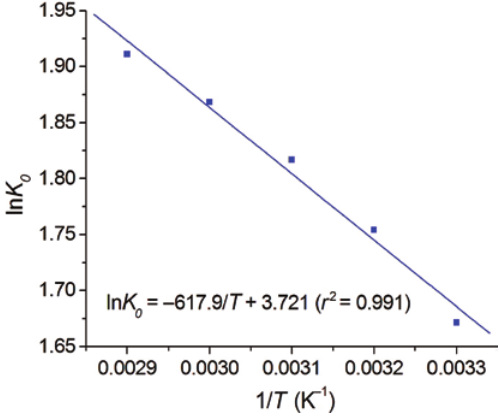
Figure 11: Van’t Hoff diagram of fluoride adsorption onto RHA/Al(OH) . 3